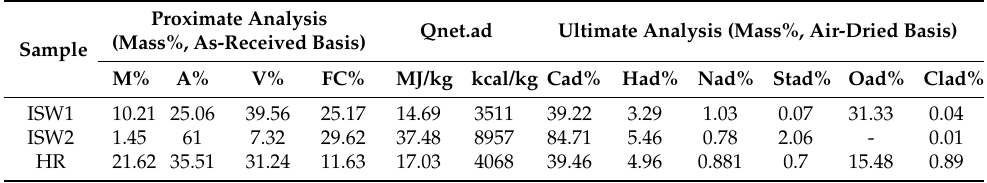
Table 2. Ultimate and proximate analyses of raw